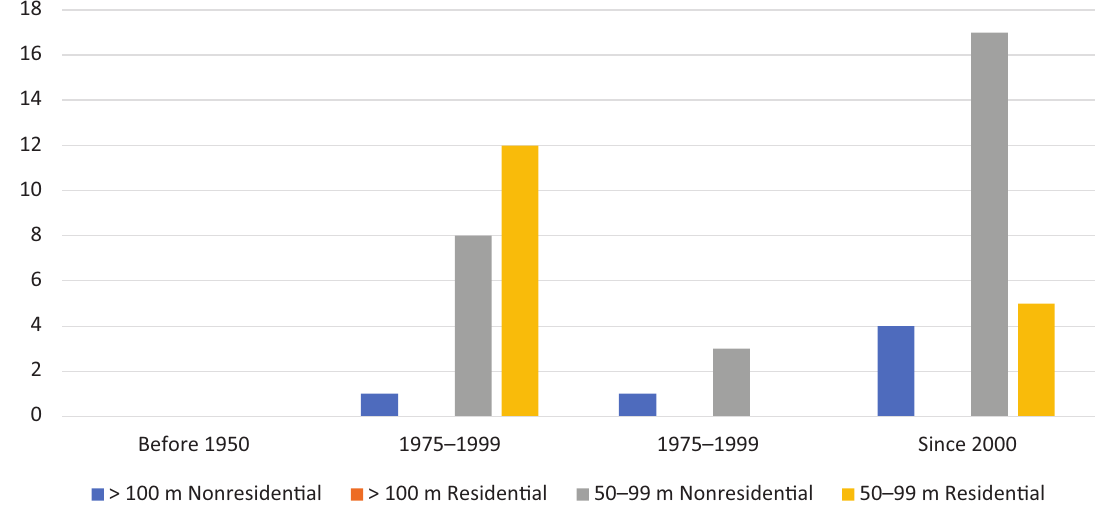
Figure 3. Construction of tall buildings (50 m and above) in Munich. Sources: Author’s work based on personal observa‐ tions, Hilgenstock (2011), Stadt München (2022), Wikipedia (2022c), and Zabel